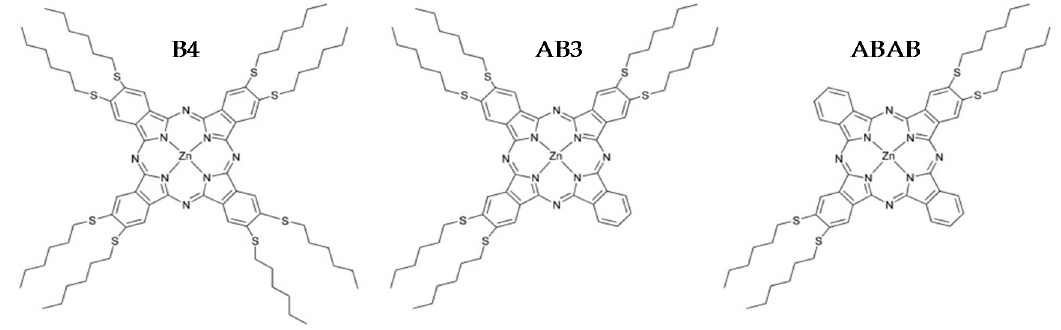
Figure 1. Molecular structure of B4 , AB3 and ABAB ZnPc, respectively.